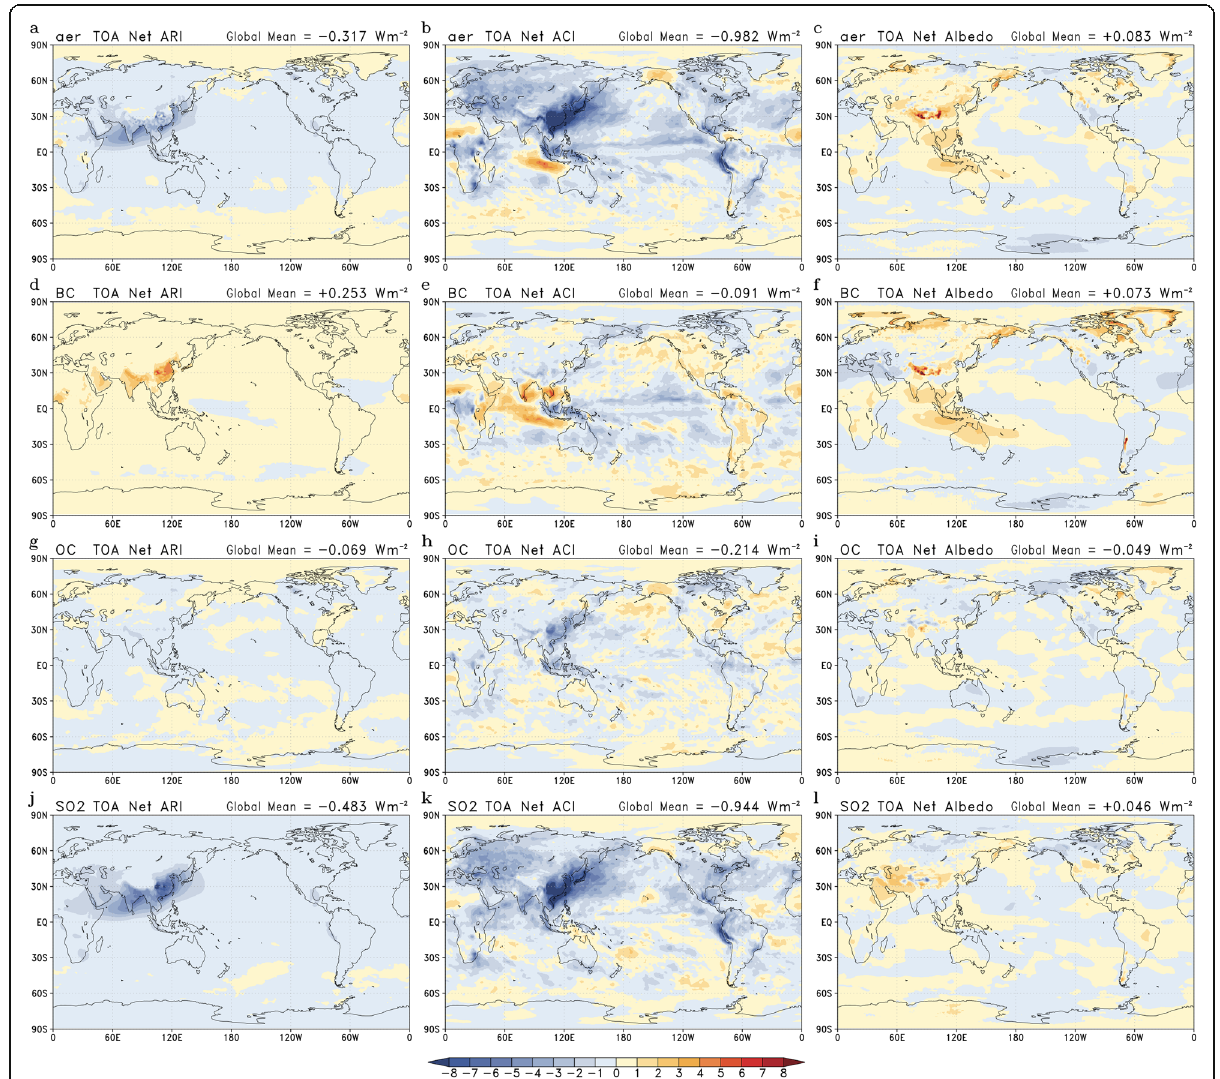
Fig. 6 Same as Fig. 4 but for the net (net, shortwave + longwave)